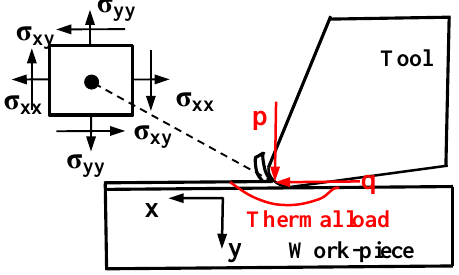
Fig.1. Two dimensional mechanical-thermal model of the cutting